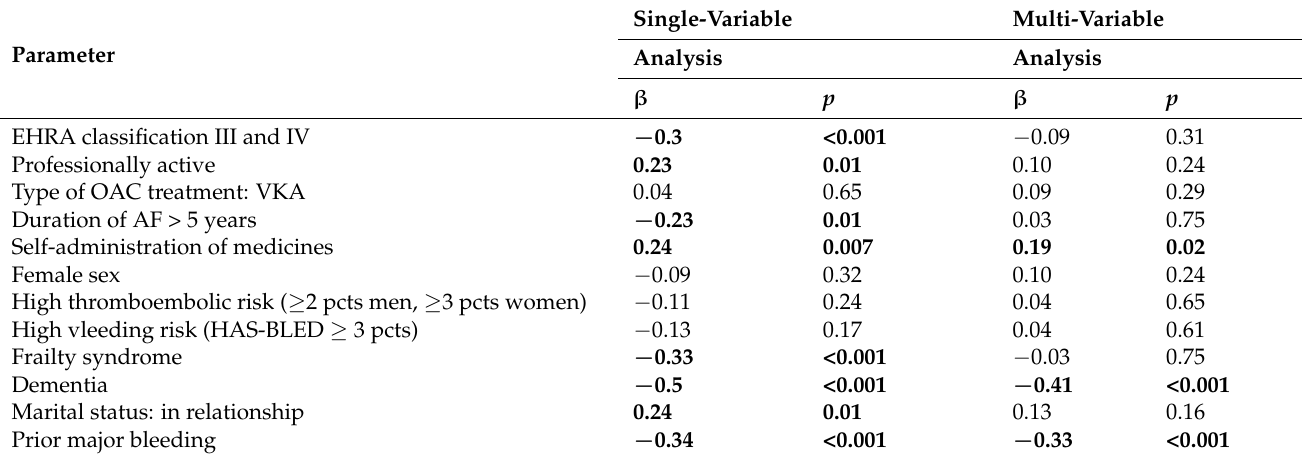
Table 4. Single- and multi-variable analysis PACT-Q2 satisfaction domain of the study group ( n = 116).